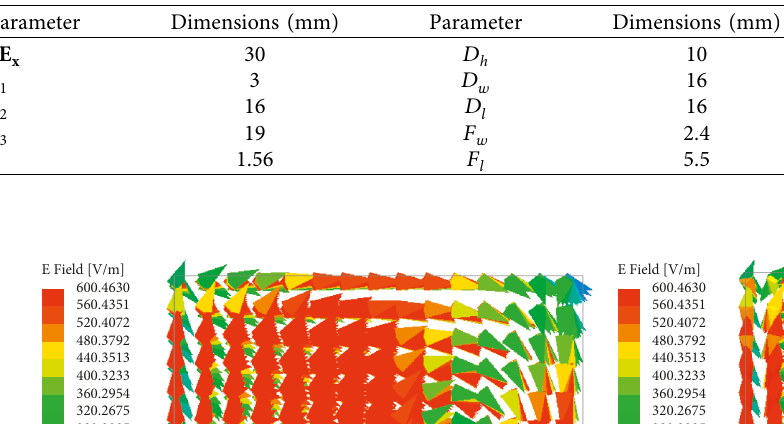
Table 1: Physical dimensions of proposed single element antenna.